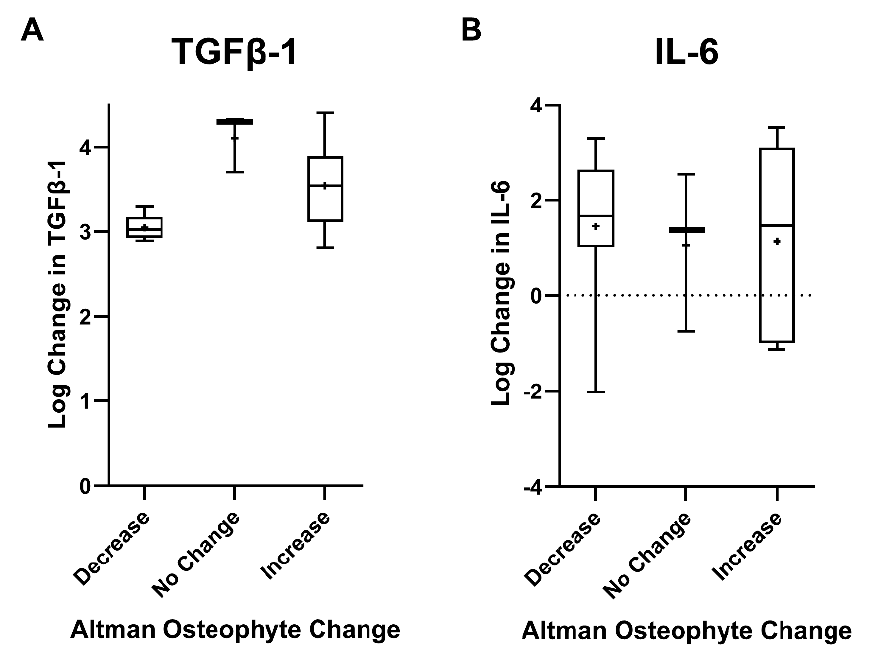
Figure 4. Box plots for the changes in synovial fluid concentrations over the course of 6 weeks of knee joint distraction, of ( A ) transforming growth factor- β 1 (TGF- β 1) and ( B ) interleukin-6 (IL-6), categorized into groups of patients with a decrease ( n = 5), no change ( n = 3) or increase ( n = 6 for TGF β -1; n = 7 for IL-6) in total Altman osteophyte score. The bar represents the median, whiskers represent the minimum and maximum value, the + represents the mean.